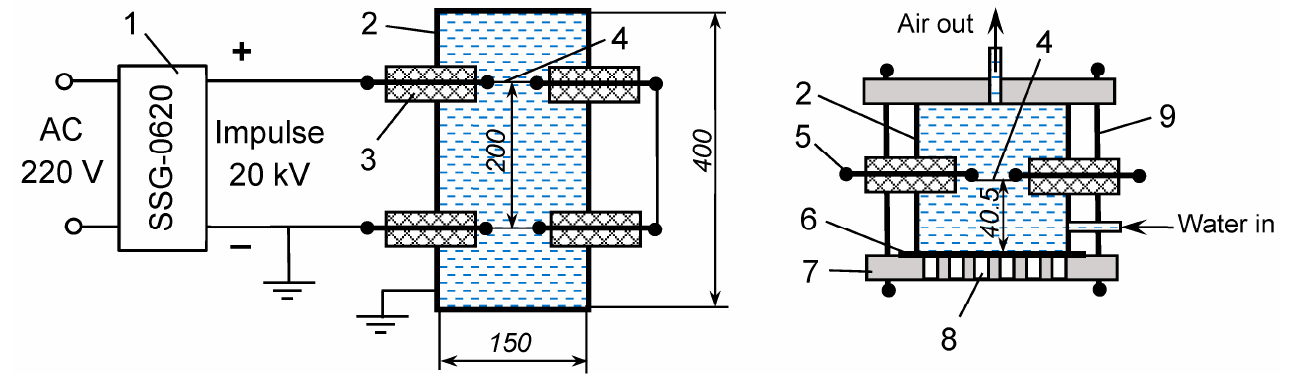
Figure 1 . Schematic diagram of the experimental setup: 1—pulse generator; 2—discharge chamber filled with water; 3—isolated electrode; 4—wire; 5—nut; 6—metallic membrane; 7—multipoint pressure-gauge body; 8—hole of 6 mm diameter; 9—stud.